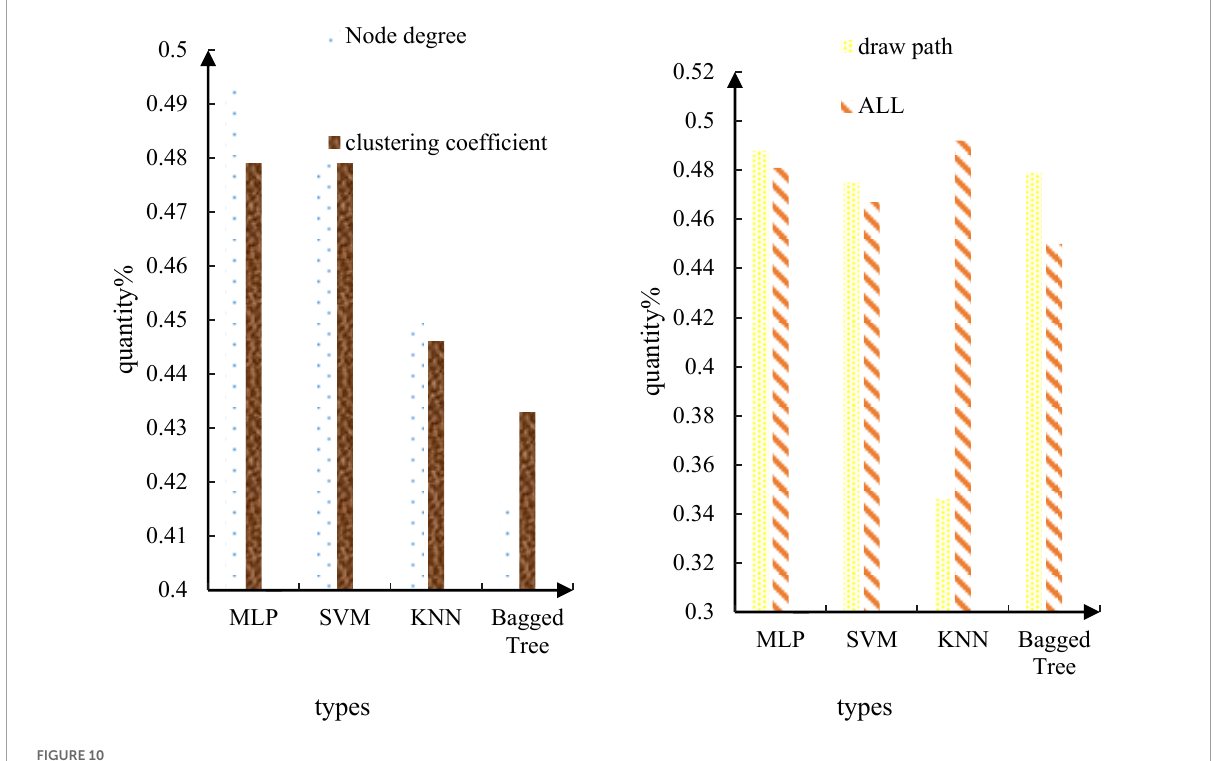
FIGURE10 Recognition results of the four-classification task based on pleasure